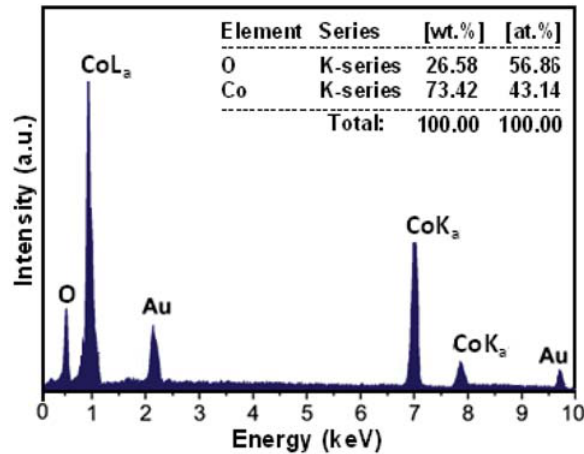
Figure 7. EDX spectrum of the Co